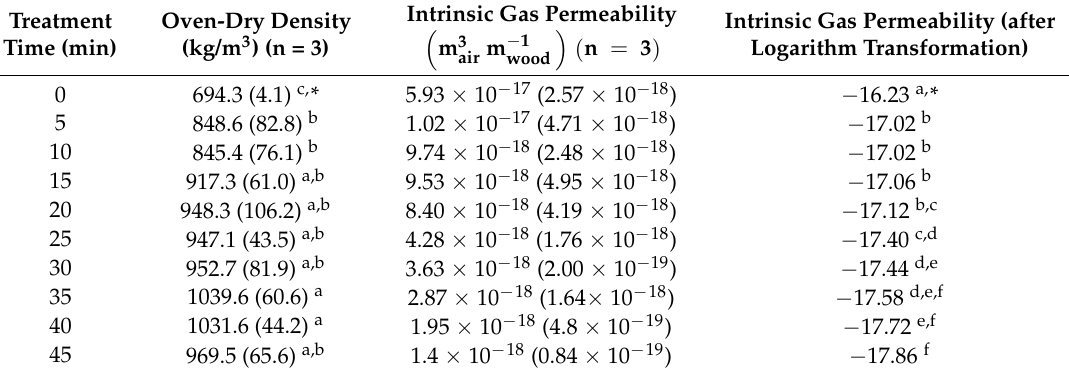
Table 4. Radial intrinsic gas permeability of the control and samples densified for different times.